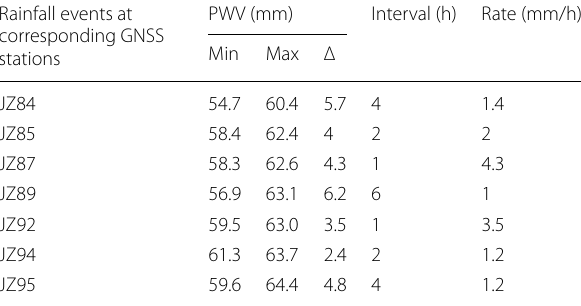
Table 5 Statistical PWV variation before several rainfall events (they are also shown by red circles in Fig. 7) Rainfall events at PWV (mm) corresponding GNSS stations